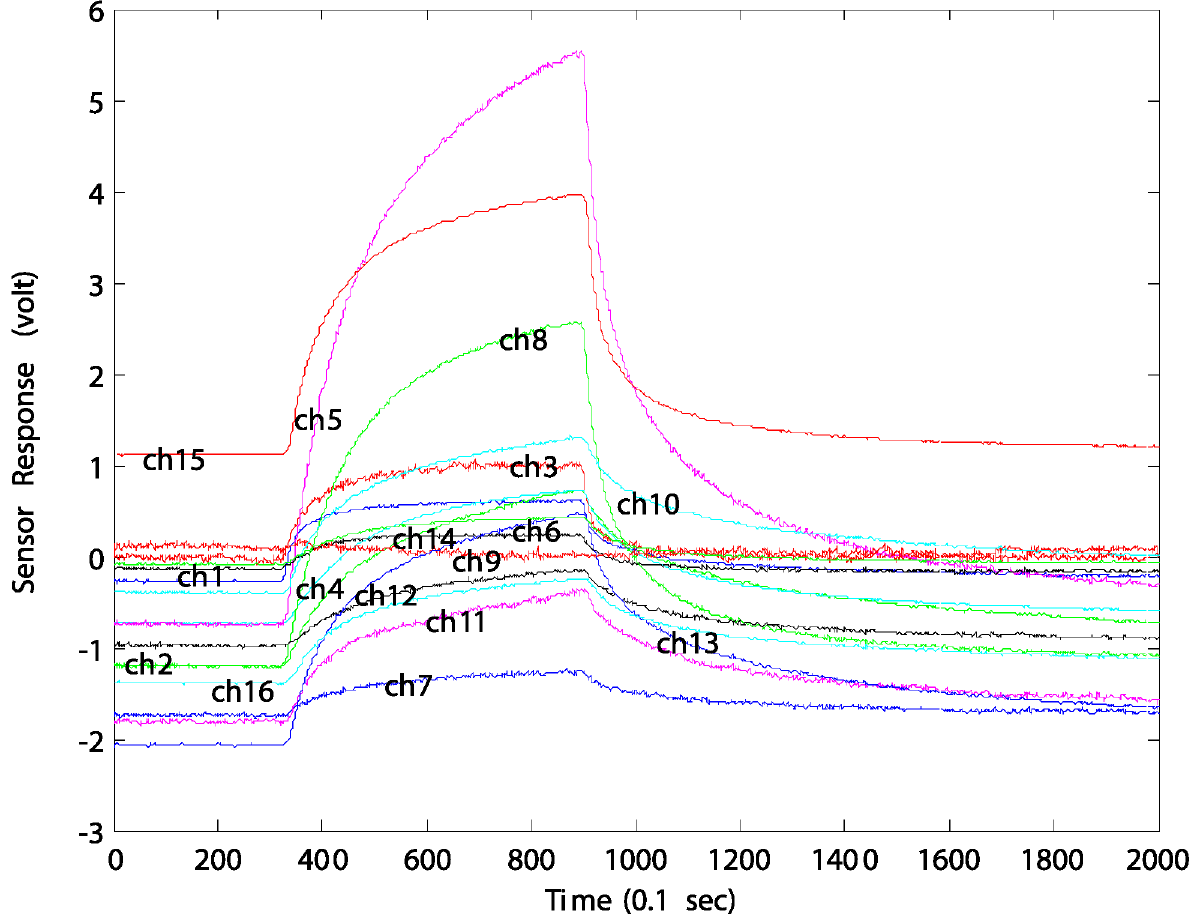
Fig 1. Typical time-response of 16 channel sensor array with respect to inflow of ethanol vapor.